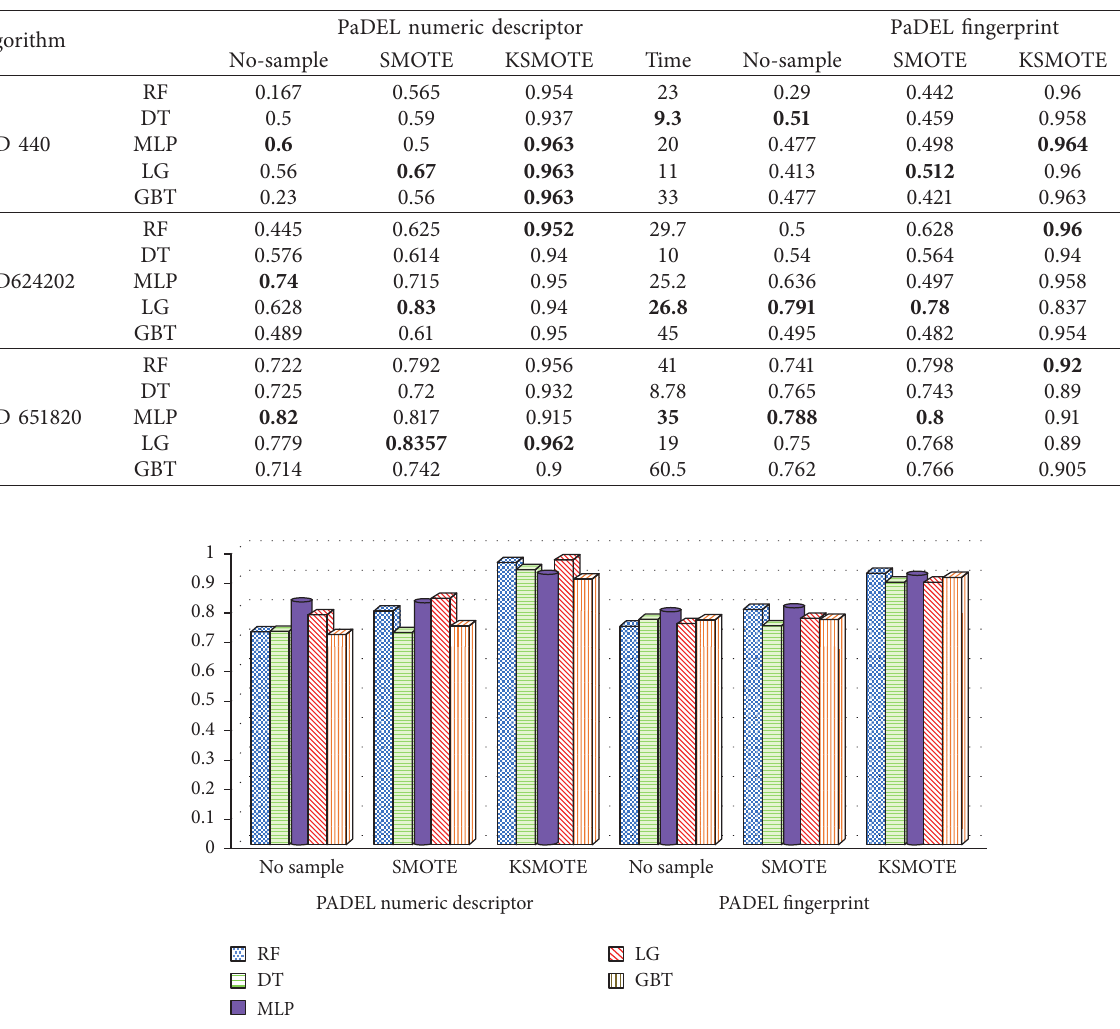
Figure 6: G-mean of numeric PaDEL descriptor and fingerprint for AID 65182.